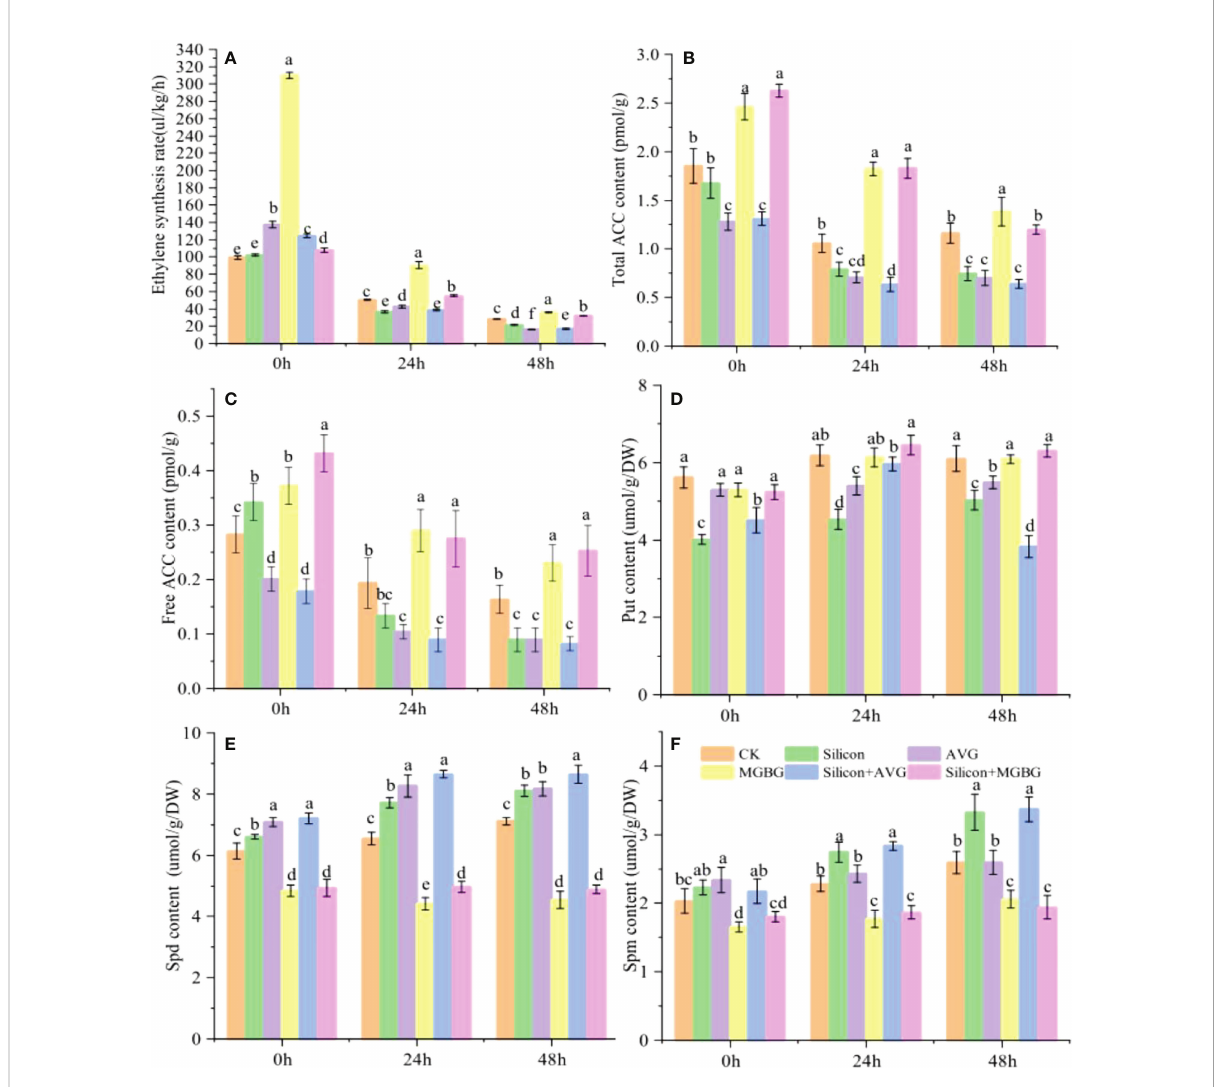
FIGURE 5 Effect of silicon on ACC and polyamine content. (A) Ethylene synthesis rate of differentially treated peach shoots. Total ACC content (B) and free ACC content (C) of peach shoots treated with different fl uids.The Put content (D) , Spd content (E) and Spd content (F) in peach shoots under different treatments.The peach shoots were treated with water, Na 2 SiO 3 (0.6 mmol/L), AVG (0.5 mmol/L) and MGBG (0.5 mmol/L) individually or in combination, and samples were taken for analysis at 0h, 24h, and 48h after treatment. Bars with different letters indicate signi fi cant differences (p < 0.05, Duncan ’ s multiple range